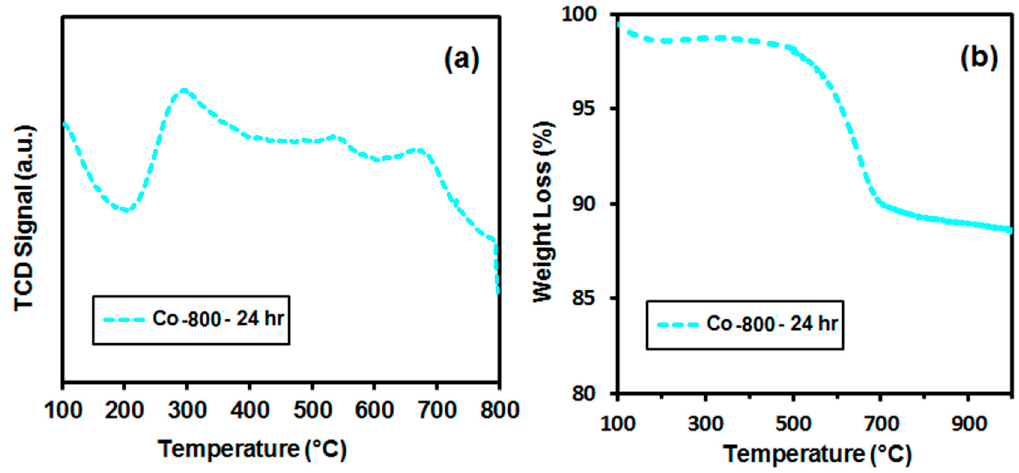
Figure 10. ( a ) Temperature-programmed oxidation and ( b ) TGA for Co-800 (5%Co/Al 2 O 3 -–rO 2 ) catalyst calcined at 800 °C after the long-term POM test at 800 °C.